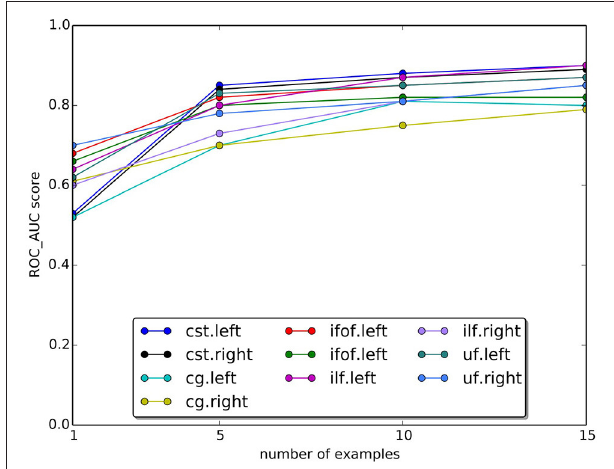
over 15 subjects. Expectedly, the AUC score increases as the number of examples increase.